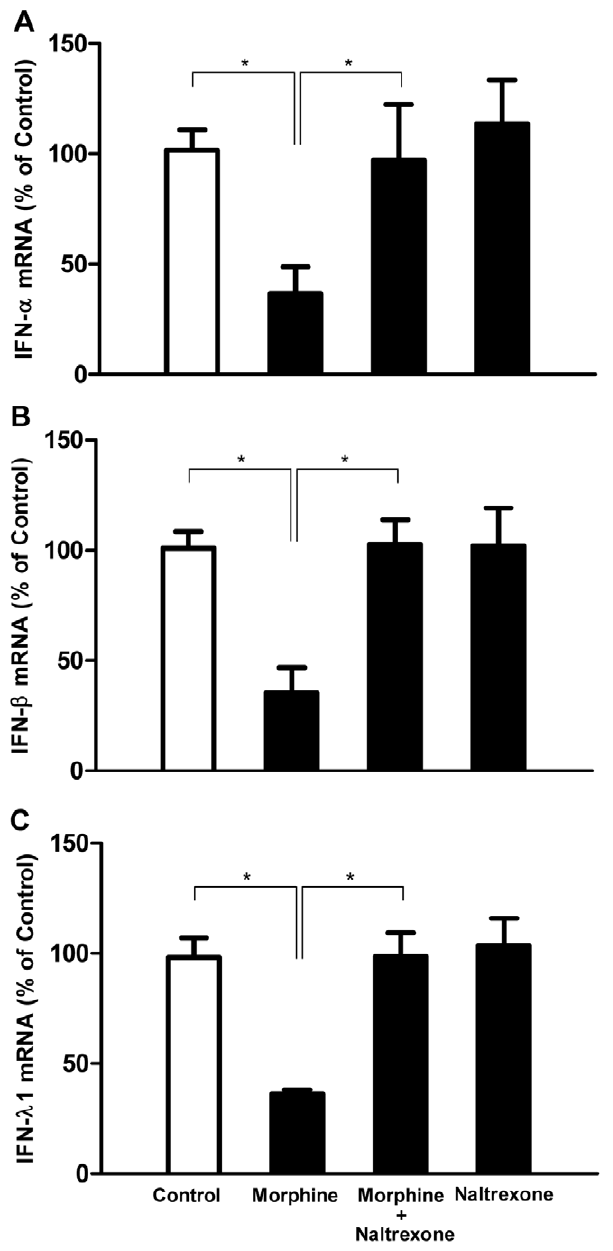
Figure 4. Effect of naltrexone on morphine-mediated down- regulation of IFNs expression. Seven-day-cultured macrophages were incubated with or without naltrexone (10 2 8 M) for 1 h before treatment with or without morphine (10 2 10 M) for 3 h. Cellular RNA was subject to the real-time RT-PCR for IFN- a (A), IFN- b (B) and IFN- l 1 mRNA (C). Data are expressed as mRNA levels in morphine treated cells (percentage of control) those untreated cells and morphine treated cells. The results represent the mean 6 SD of three independent experiments. Statistical analysis was performed using one-way analysis of variance, and significance is shown with *P , 0.05 (morphine vs control or morphine vs morphine + naltrexone).